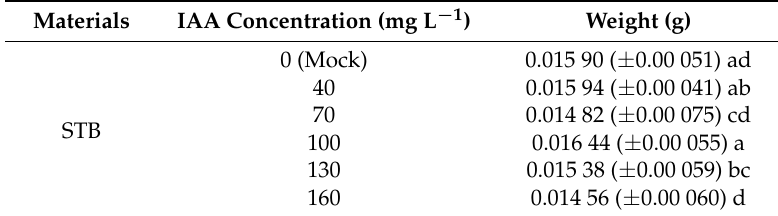
Table 3. Effects of IAA on the fruit of STB